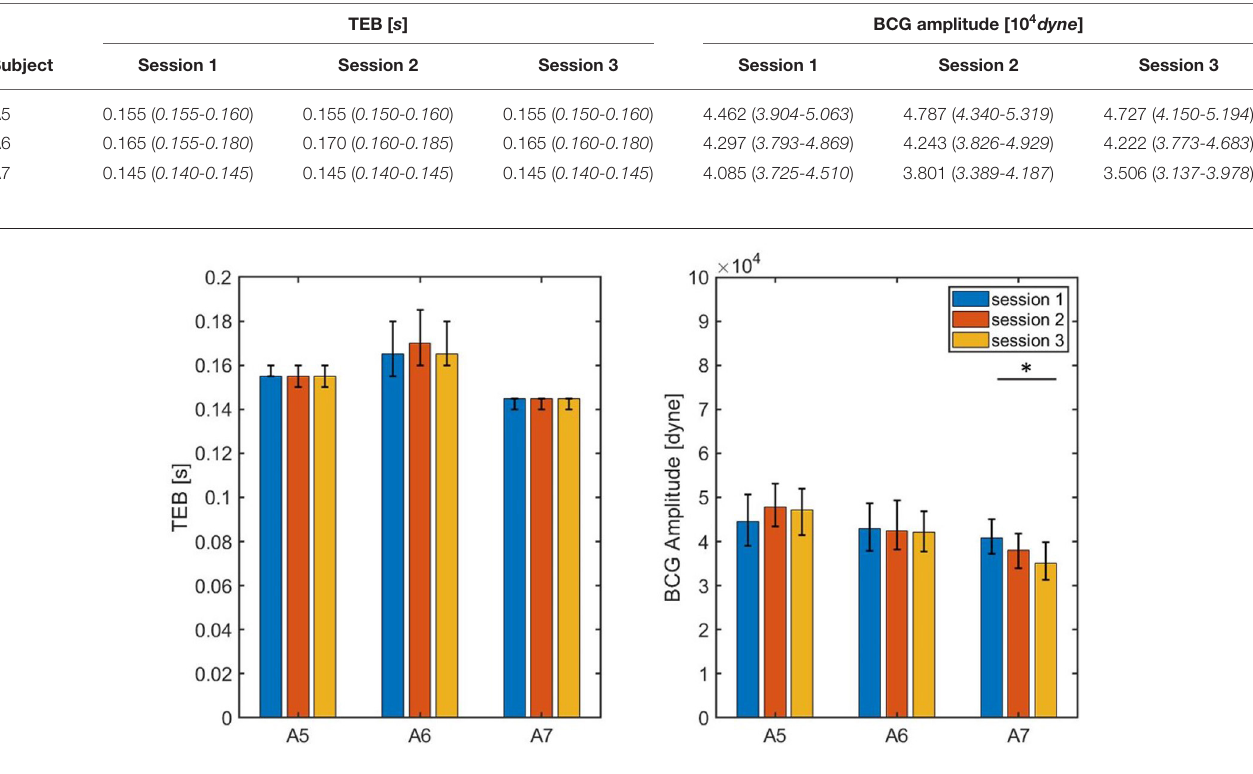
FIGURE 12 | Bar chart summarizing the values of TEB and BCG amplitude measured on three subjects during three consecutive sessions of data acquisition, each lasting 3 min. The bar height correspond to the medians, the black lines correspond to the 25 th and 75 th percentiles.* P < 0.05 among sessions.